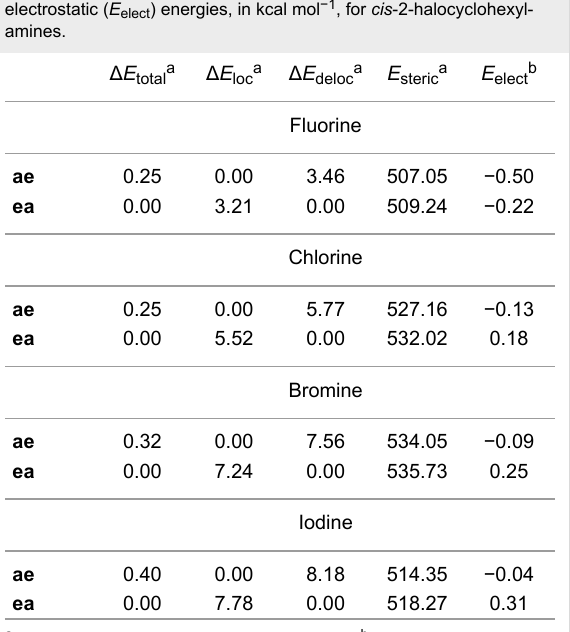
Table 4: Variation in total ( Δ E total ), localized ( Δ E loc ) and delocalization ( Δ E deloc ) energies; and absolute total steric exchange ( E steric ) and